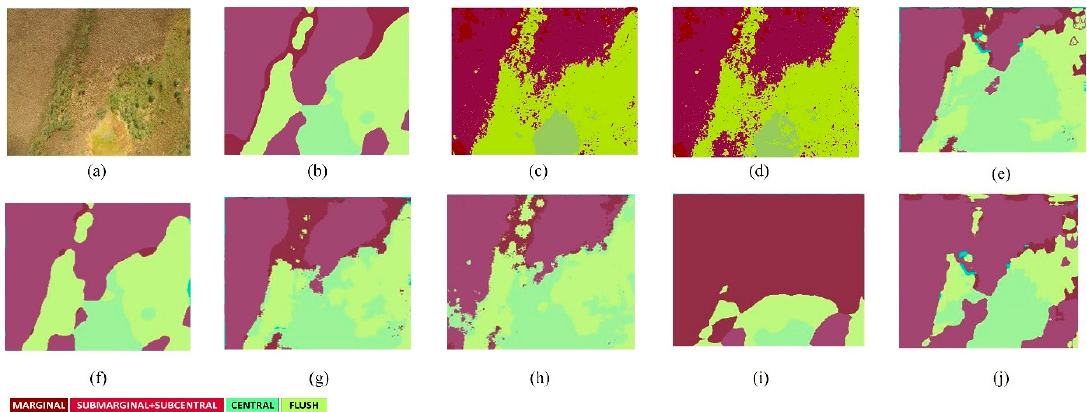
Figure 11. Segmentation results. ( a ) Drone image, ( b ) ground truth labelled image, ( c ) machine learning (ML) (random forest (RF) + Graph cut) segmentation using RGB features, ( d ) ML (RF + Graph cut) segmentation using RGB and textural features, ( e ) deep learning (DL) semantic